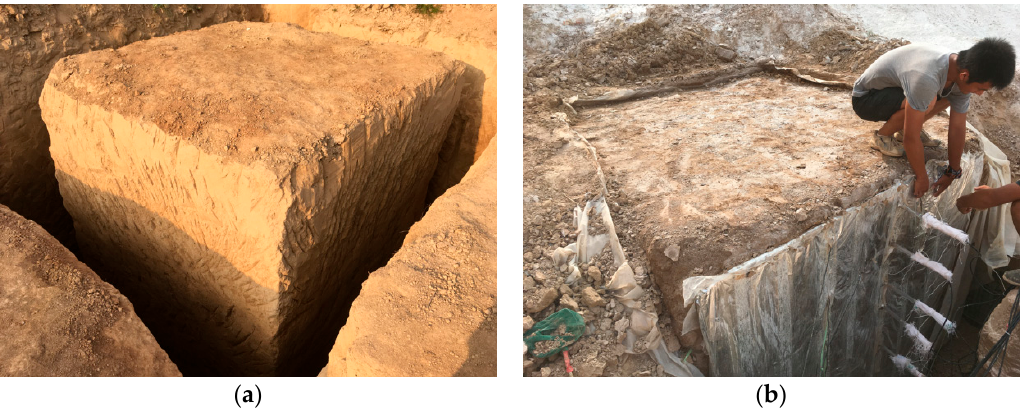
Figure 3. Field irrigation experiment: ( a ) field undisturbed loess column; ( b ) instrument of tensiometers.